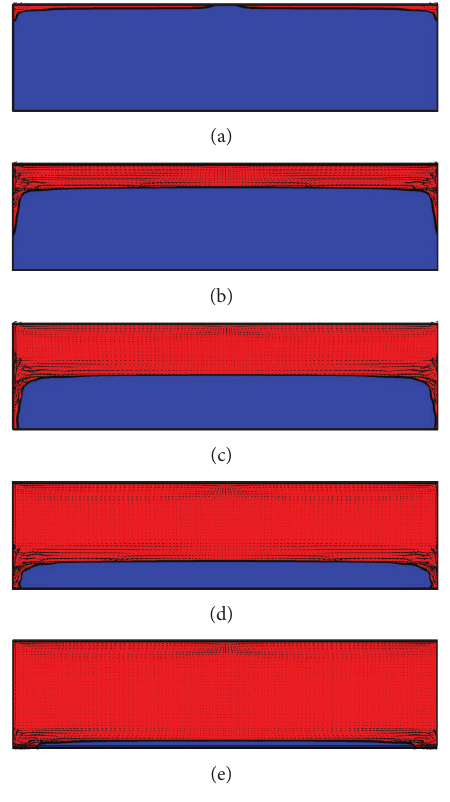
Figure 7: Melting process in evolved DS furnace for power distribu- tion ratio of 5:5: (a) 480 min; (b) 540 min; (c) 600 min; (d) 660 min; (e) 720 min.